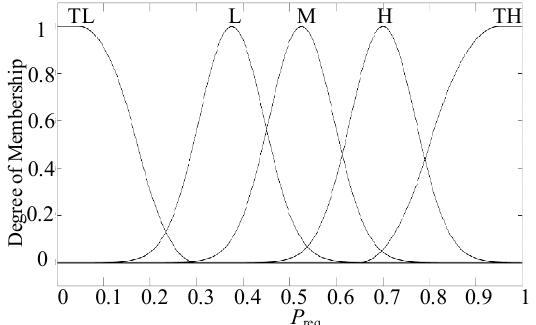
Figure 6. Membership function of P req .